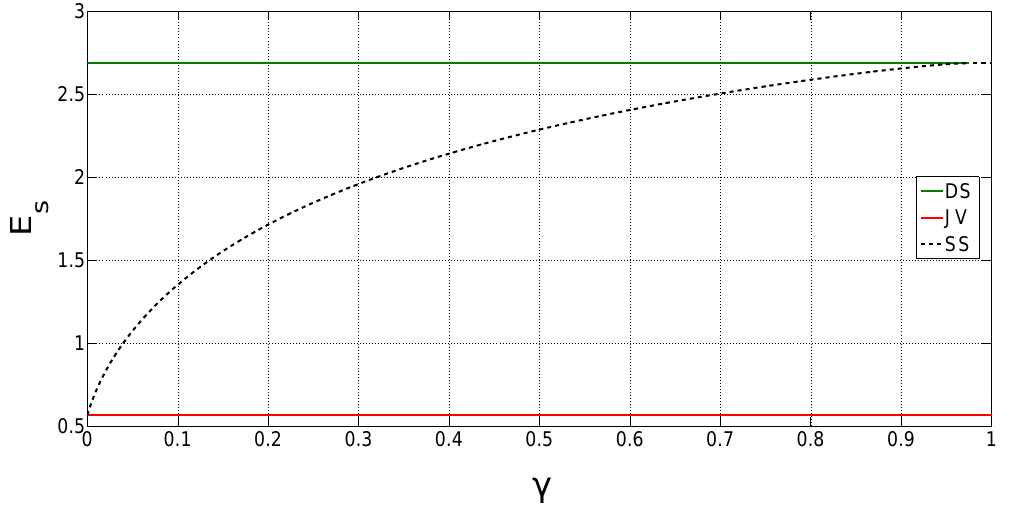
Figure 11: Excitation energy of stationary (unstable) staggered solitons (labeled ‘SS’) as a = 2 π n function of γ at ν = 0.005, P (black dashed line). The energy of the stable dark c 0 soliton (top green line, labeled ‘DS’) and Josephson vortex (lower red line, labeled ‘JV’) are also